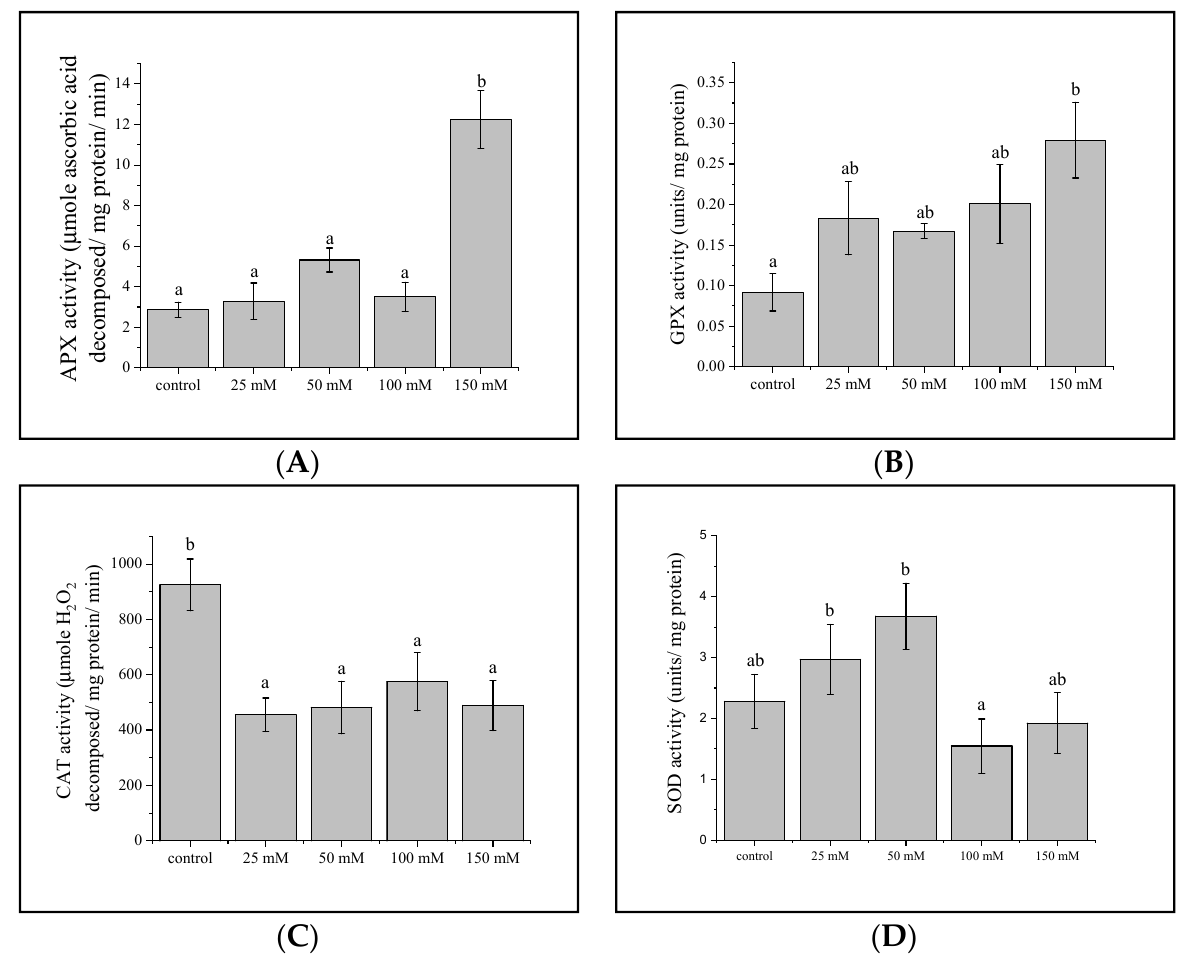
Figure 2. Antioxidant enzyme activity in gac leaves in response to salinity stress. Activity assayed included ( A ) APX, ( B ) GPX, ( C ) CAT, and ( D ) SOD. Values are means ± SE (n = 6). Different lowercase letters indicate significant differences between treatments (p < 0.05).